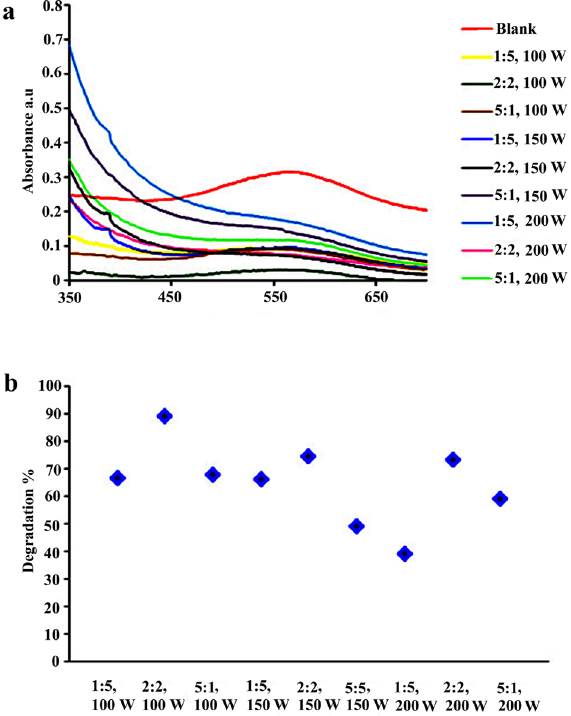
Figure 12. Effect of ultrasonic pulse and power on decontamination of AB113. S–BaSO 4 –BaTiO 3 was used as the piezocatalyst: ( a ) related spectrum and ( b ) degradation